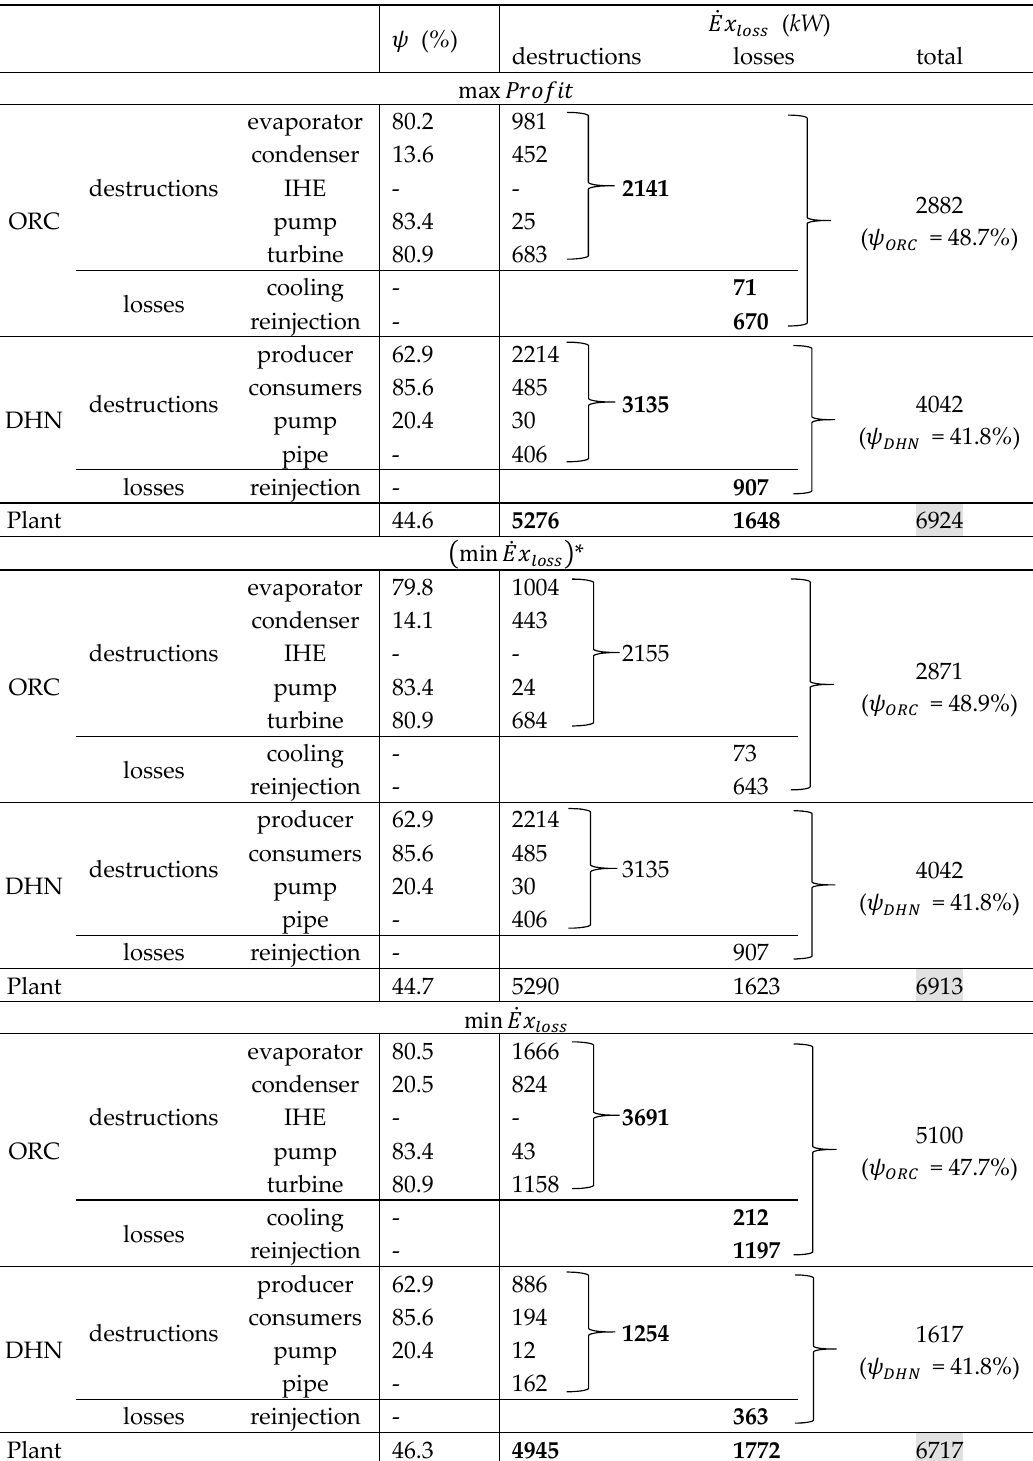
Table 4. Exergetic efficiency ( ψ ) and detail of exergy destroyed and lost for the three different studied cases.